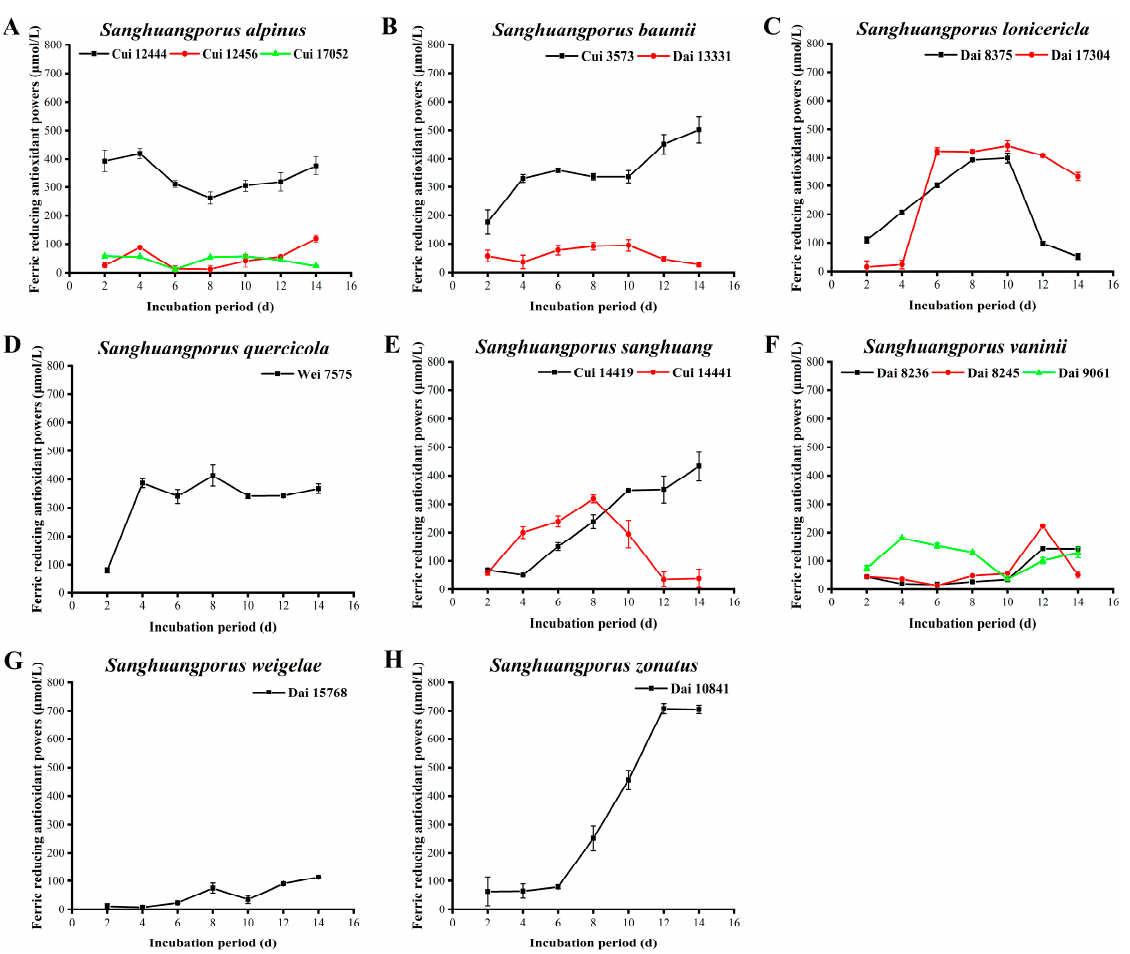
Figure 12. Variations in ferric reducing ability of plasma during submerged fermentation of 15 wild strains from 8 species of Sanghuangporus . ( A ) Sanghuangporus alpinus Cui 12444, Cui 12456, and Cui 17052. ( B ) Sanghuangporus baumii Cui 3573 and Dai 13331. ( C ) Sanghuangporus lonicericola Dai 8375 and Dai 17304. ( D ) Sanghuangporus quercicola Wei 7575. ( E ) Sanghuangporus sanghuang Cui 14419 and Cui 14441. ( F ) Sanghuangporus vaninii Dai 8236, Dai 8245, and Dai 9061. ( G ) Sanghuangporus weigelae Dai 15768. ( H ) Sanghuangporus zonatus Dai